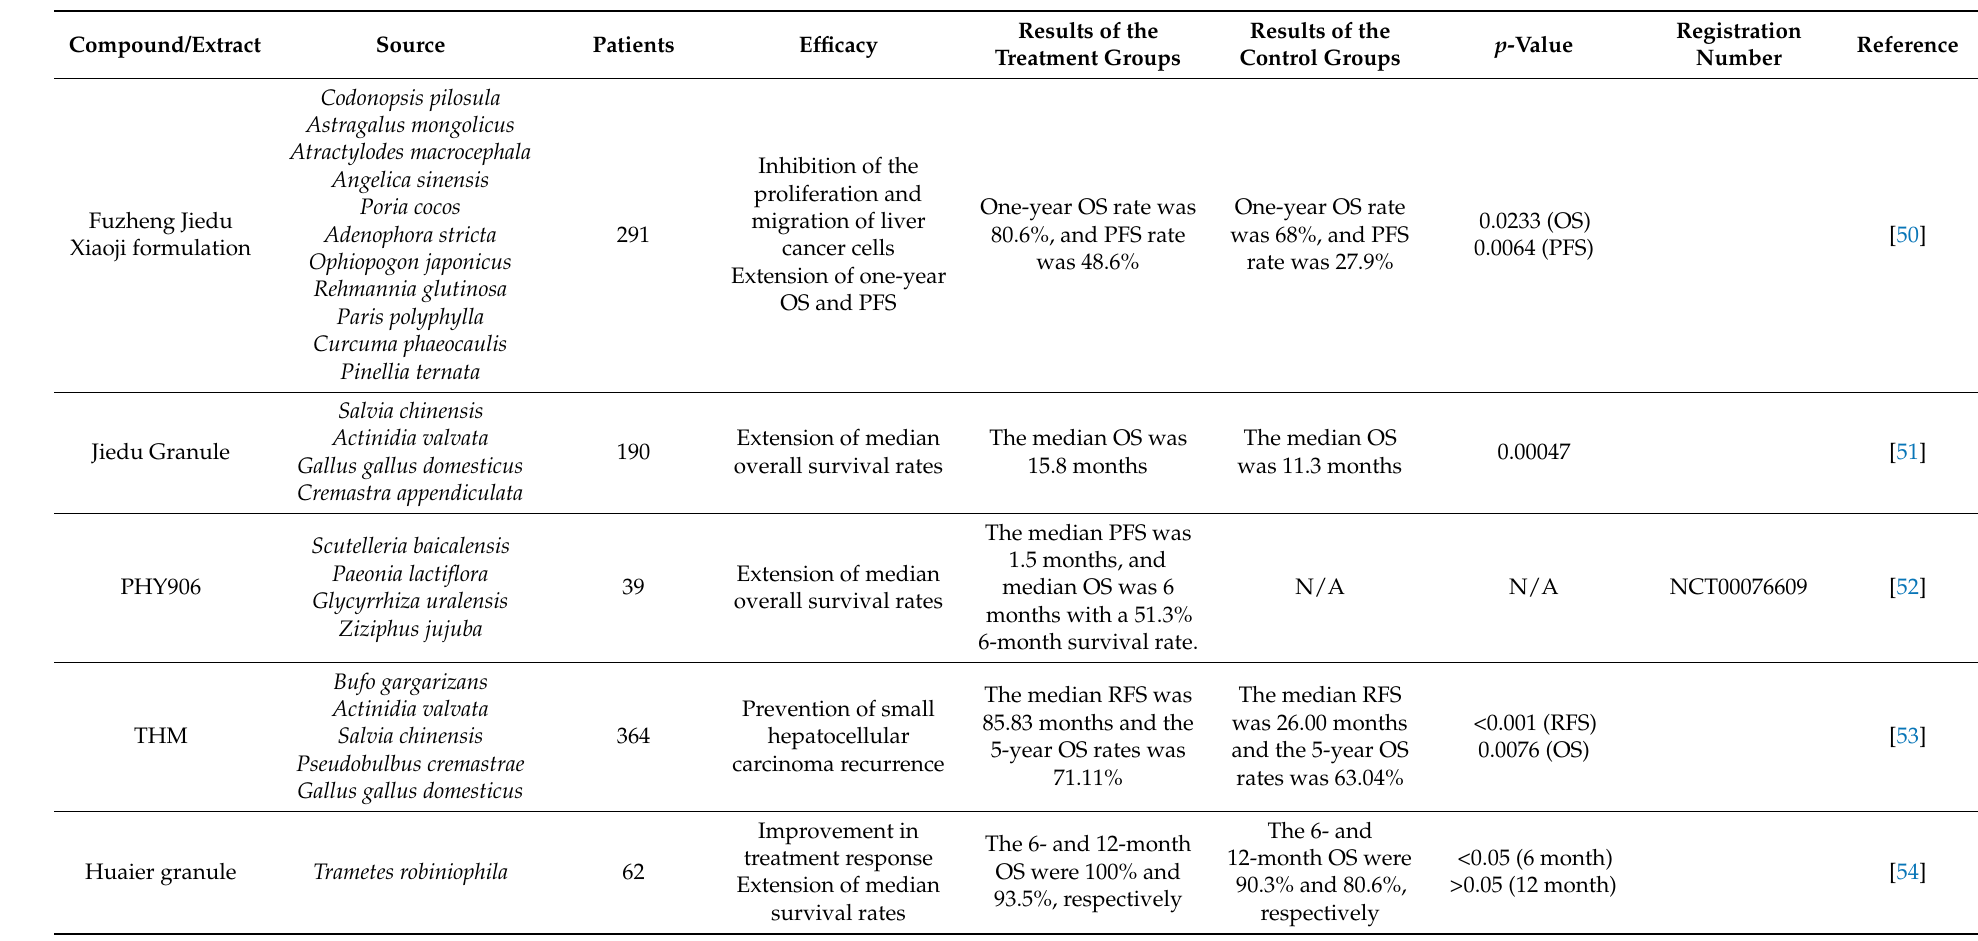
Table 6. Clinical